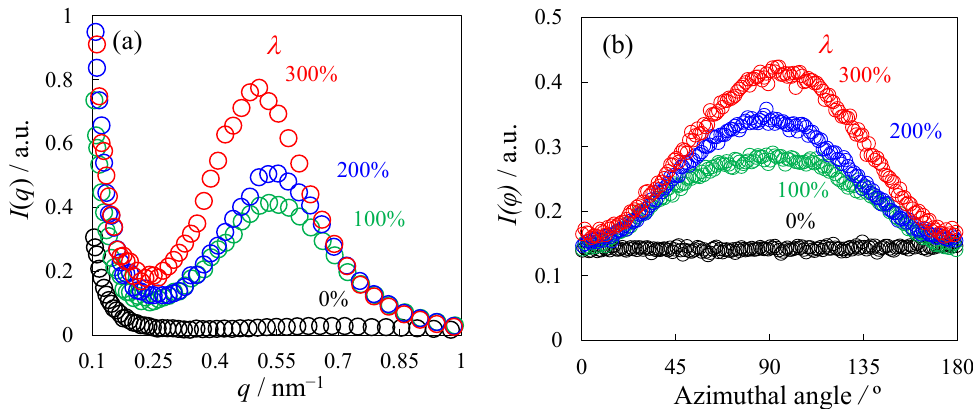
Figure 3. One-dimensional SAXS profiles of the heat-elongated TPU films obtained at various elon- gation ratios λ : ( a ) q dependence, ( b ) azimuthal angle dependence. The DSC curves at the endothermic peak, which are needed to melt the heat-elon- gated TPU films, are shown in Figure 4. The heat of fusion Δ H obtained by the peak area is shown in Figure 4. The change in Δ H was slight with an elongation ratio of λ , suggesting that the change in crystallinity was slight with λ , although the SAXS intensity increased, as shown in Figure 3a. Thus, the increase in the SAXS peak intensity shown in Figure 3a is not attributed to the increase in the crystallinity, but to the densification of the HS do- mains in the stacked structure.